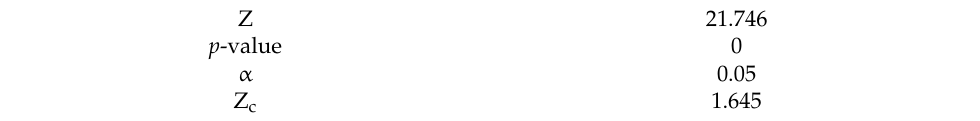
Table 20. Z-test results.